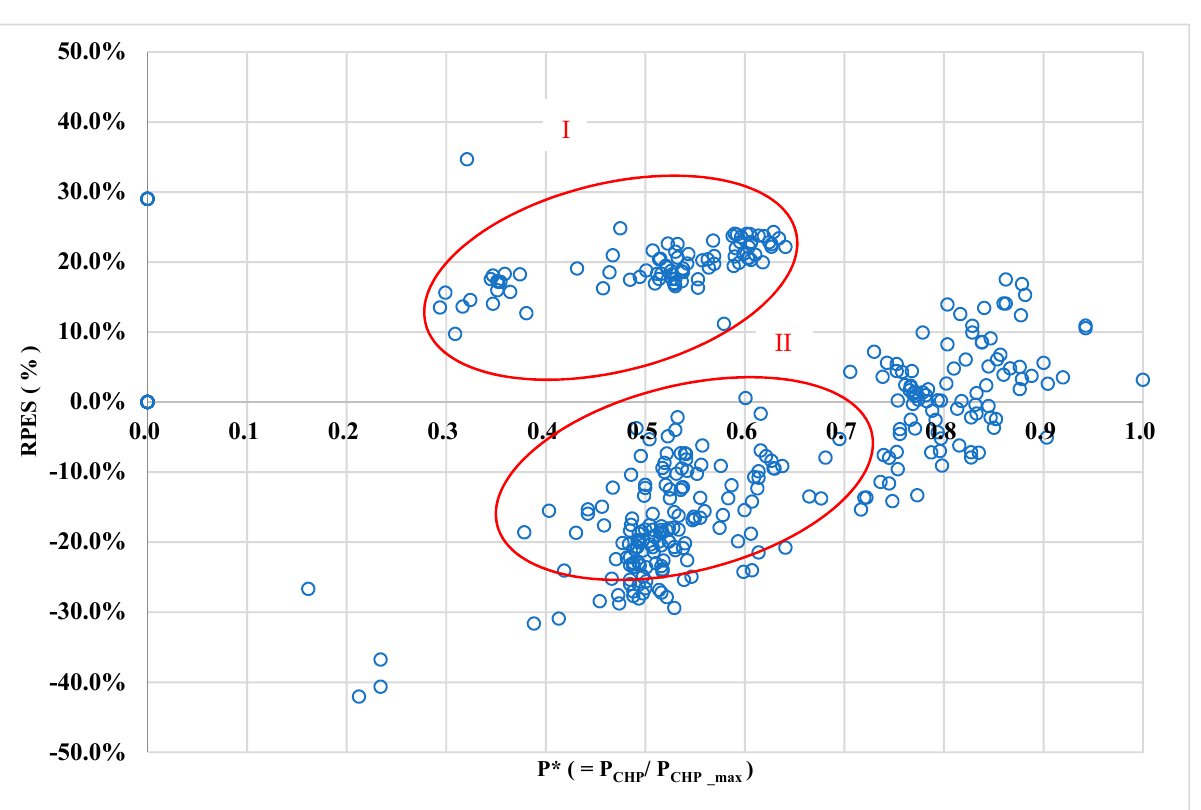
Figure 20. Distributions between the daily RPES values and the power production by the CHP prime movers for Case C (Note: The red circle indicates the operating event regime for a specific period. See the main text for details).